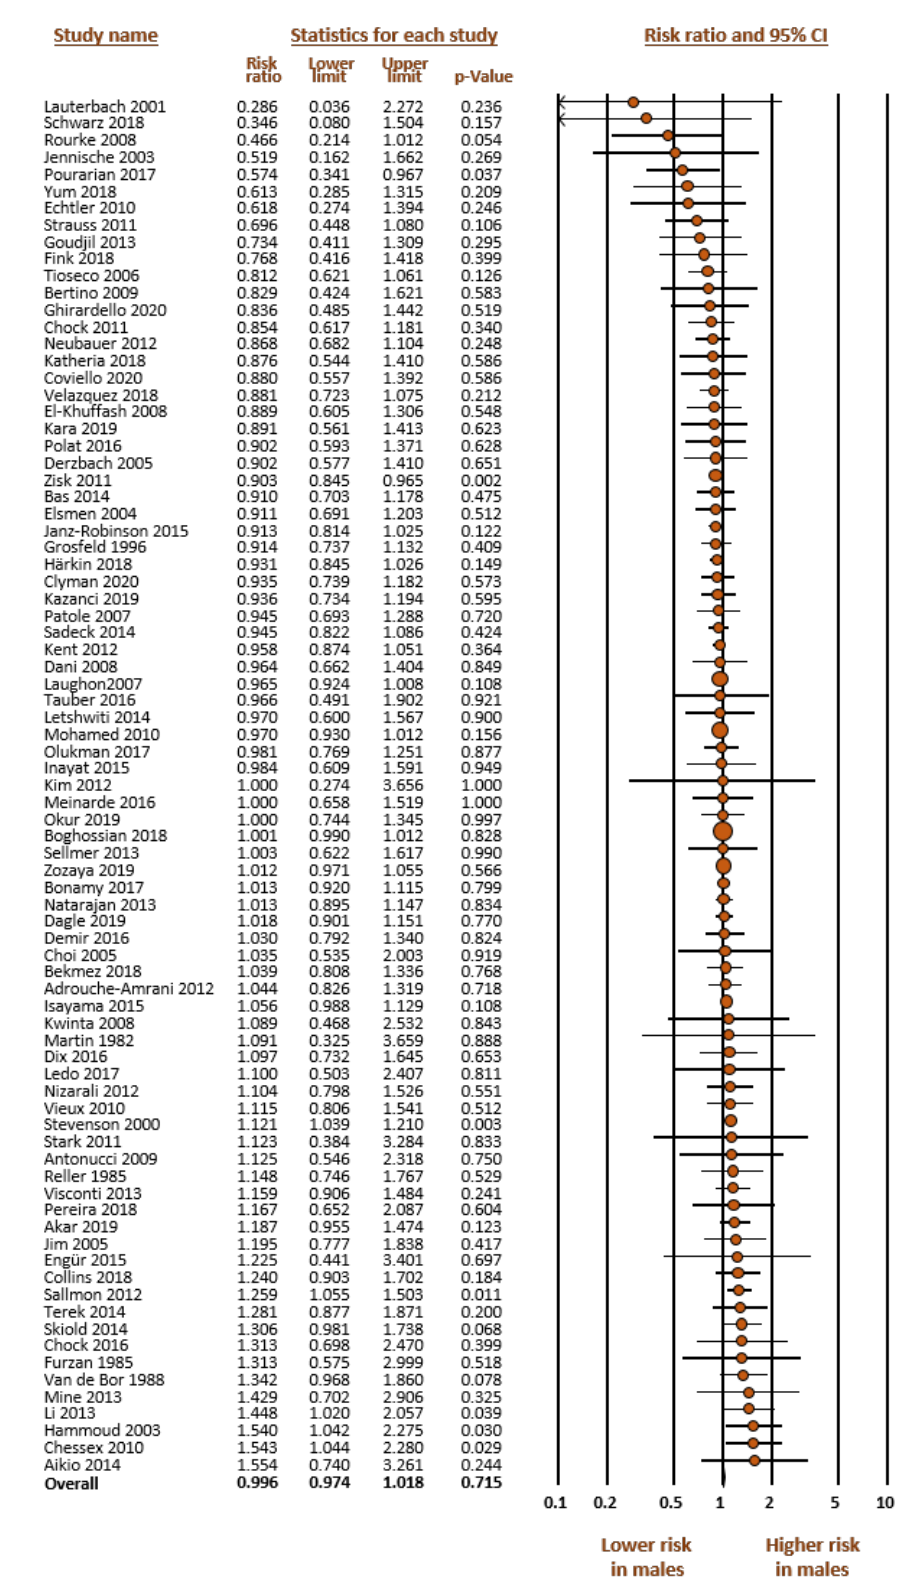
Figure 2. Meta-analysis on the association between sex of preterm newborns and risk of developing hemodynamically significant patent ductus arteriosus (hsPDA). Large ductal shunts were compared with small shunts plus closed DA. The median incidence of hsPDA in the cohorts was 36.7% (range 10.7 to 83.6%); CI: confidence interval; Risk ratio above 1 means higher risk in